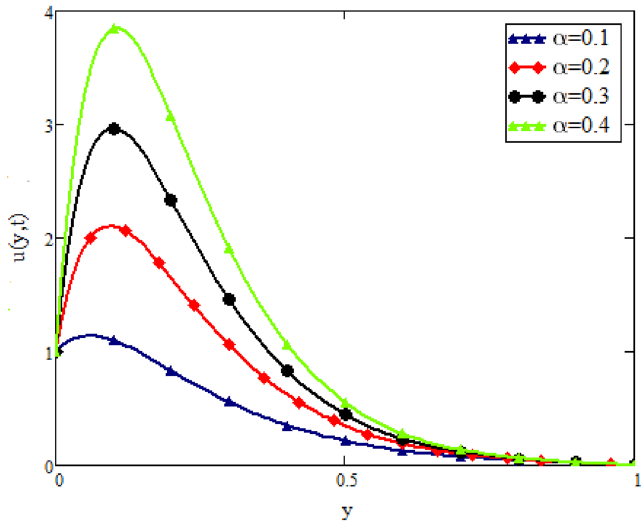
Figure 2. Impact of α on velocity distribution when t = 1 , Gr = 1.5 , Gm = 1.5 , Pr = 50 , Sc = 20 , and β = 2